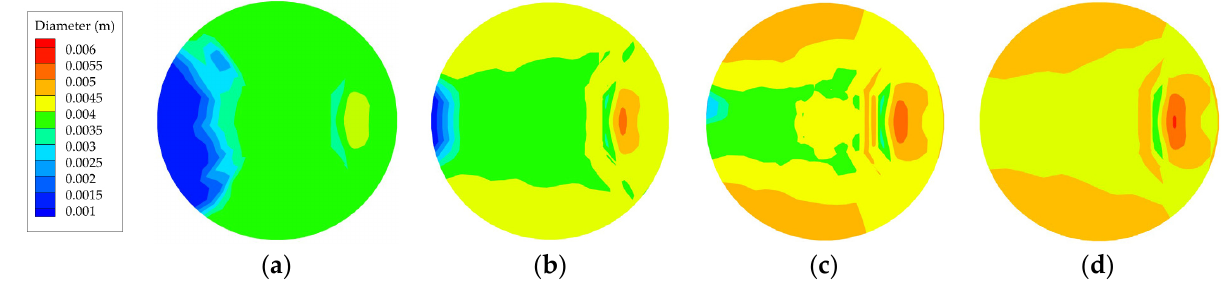
Figure 6. Bubble size distribution in Y = 0.3 m plane at different flow rates: ( a ) 360 NL/h; ( b ) 720 NL/h; ( c ) 900 NL/h; ( d ) 1080